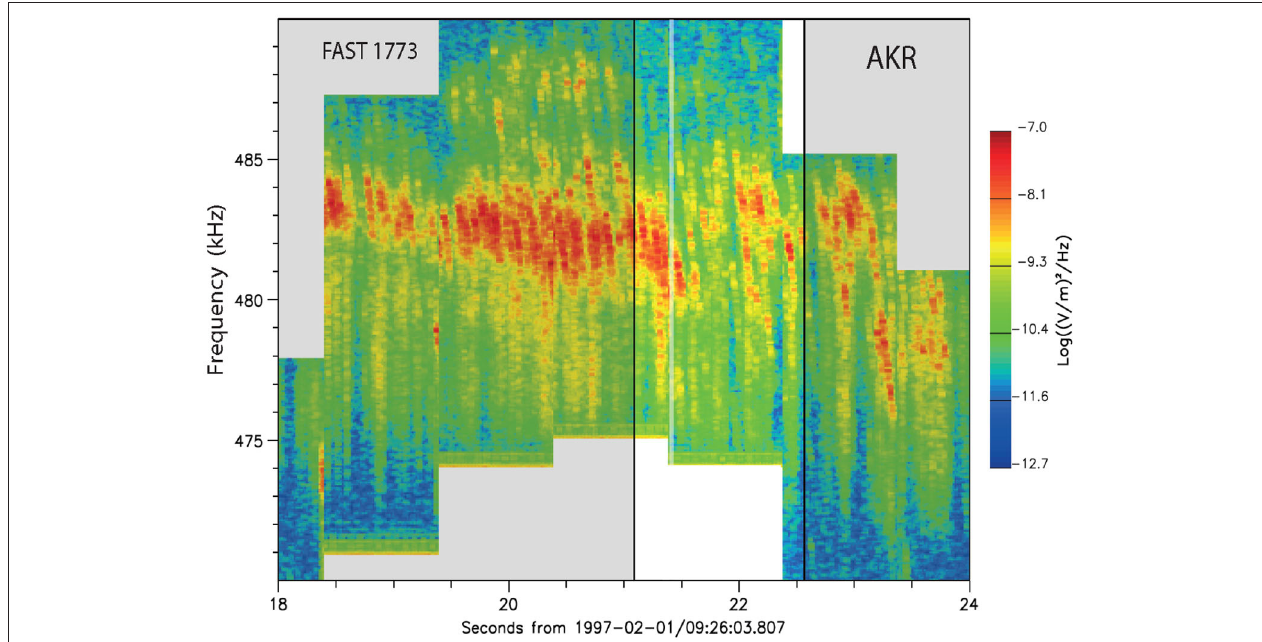
FIGURE 2 | Another example of narrow band emission in auroral kilometric radiation [after 25] observed by FAST with no high-resolution observations available. In this event time resolution does not permit resolving all microscopic emission sources. Only few spatially downward (upward in frequency) moving sources can be identified. The emission band is about stably in spatial (and frequency) location. Apparently most moving microscopic radiation sources move upward in space (downward in frequency) from their location of strongest